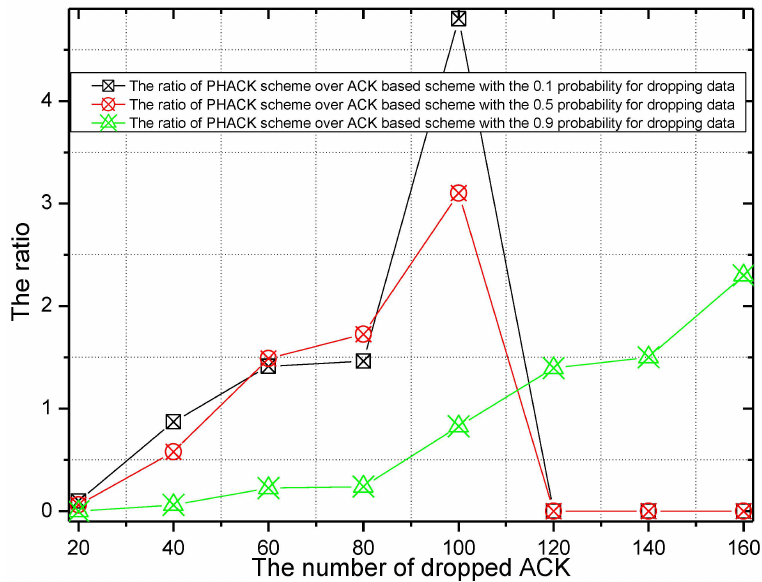
Figure 19. The ACK dropping ratio of PHACK over the ACK-based scheme.